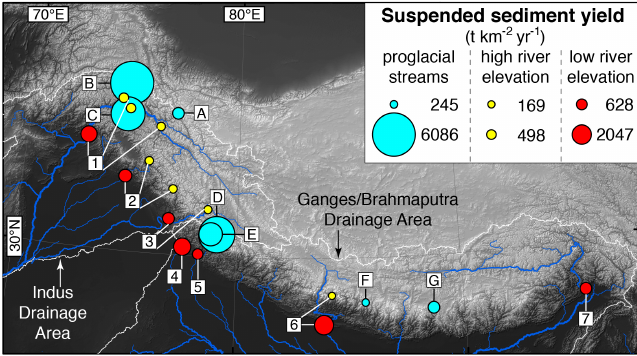
Fig. 12. Compilation of mean annual suspended sediment yield measurements in proglacial streams ( > 2500ma.s.l.), upstream river catch- ments ( > 2000ma.s.l.), and at outlet locations of major rivers (100–600ma.s.l.). Letters (A–G) and numbers (1–7) refer to respective references given in Tables 4 and 5. Note the high suspended sediment yield contribution of proglacial